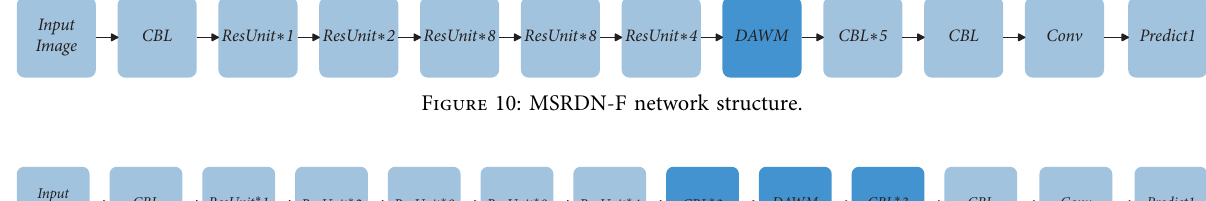
Figure 11: MSRDN-M network structure.